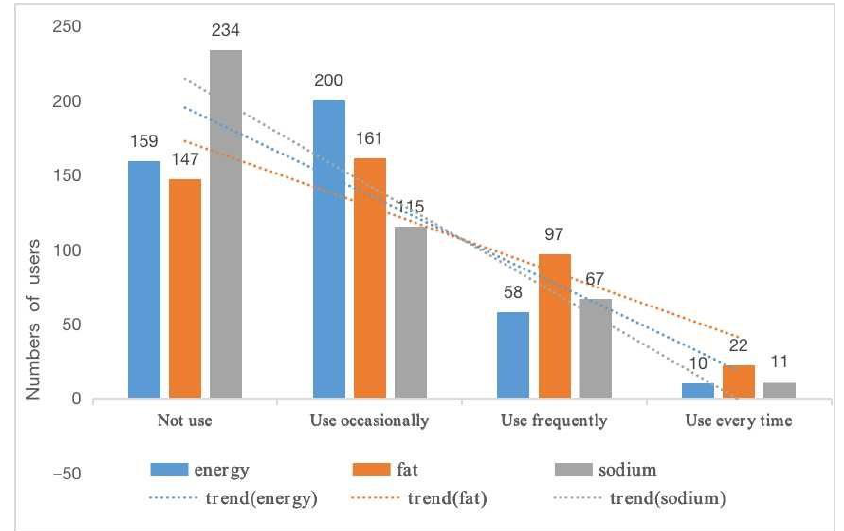
Figure 1. Using Status of three types of nutritional information.